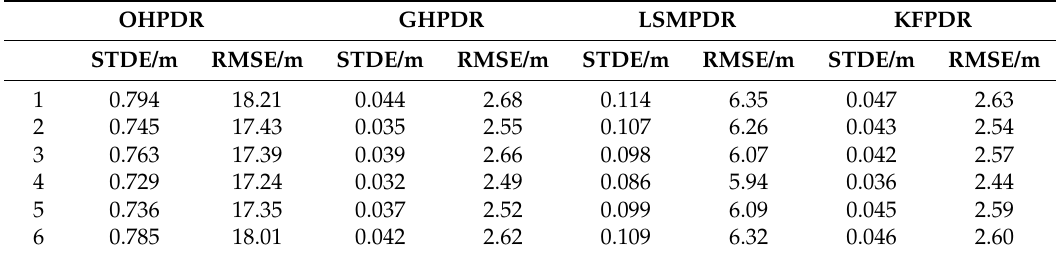
Table 4. Positioning analysis for different solutions associated with PDR in B–C area on the 5th floor.